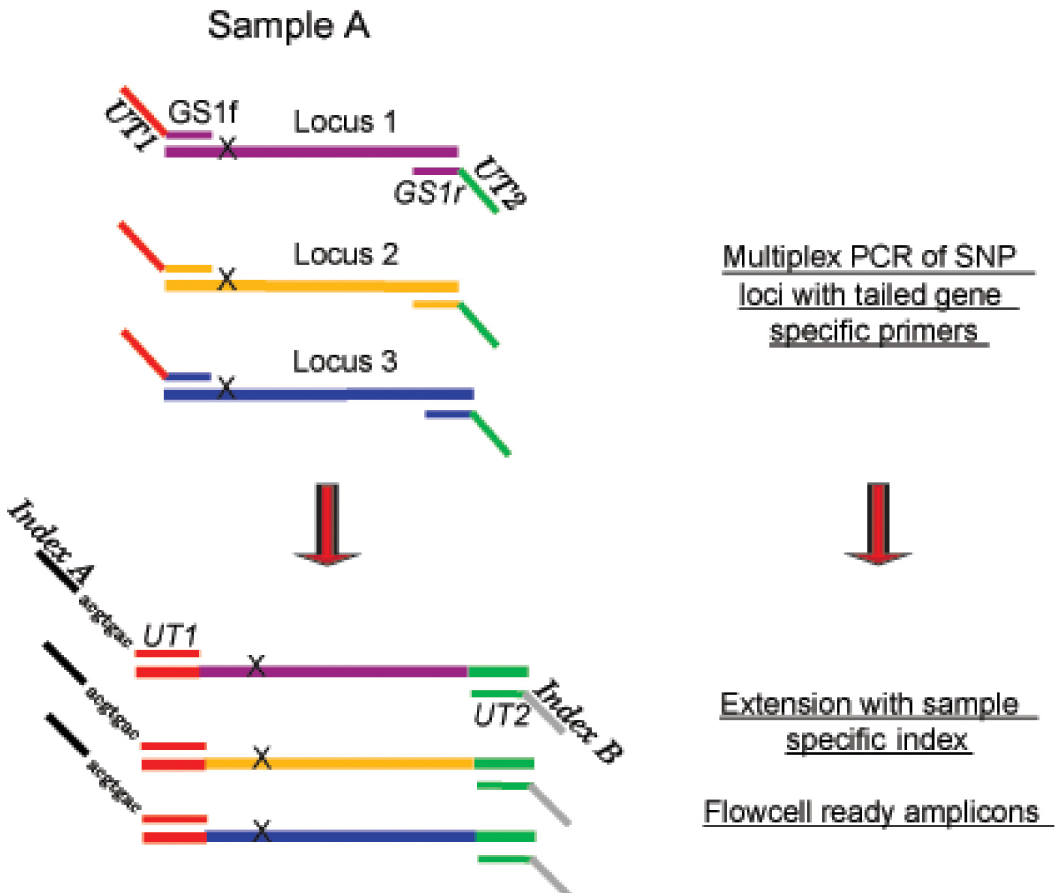
Fig 1. Illustration of universal tail approach. In a multiplex PCR, all M . tuberculosis gene specific targets are amplified with universal tailed primers. A second PCR extends the amplicon with a sample specific index that allows for several samples to be pooled together for sequencing. GS: gene specific primer; UT: universal tail sequence; Index A: Primer that includes the UT1 sequence and Illumina index sequence; Index. B: primer that includes the UT2 sequence and the Illumina sequence to bind to the flowcell.